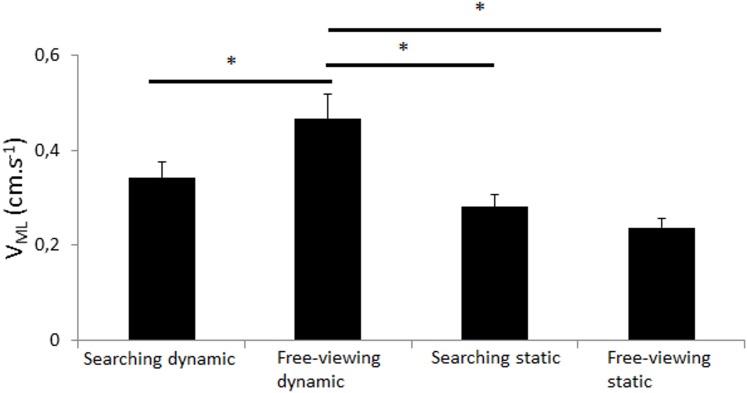
Mean velocity in medio-lateral.Mean velocity in medio-lateral (in cm.s-1) in both searching task (static and dynamic) and in both free-viewing task (static and dynamic). Vertical bars indicate the standard error. Horizontal bars indicate significant interactions.